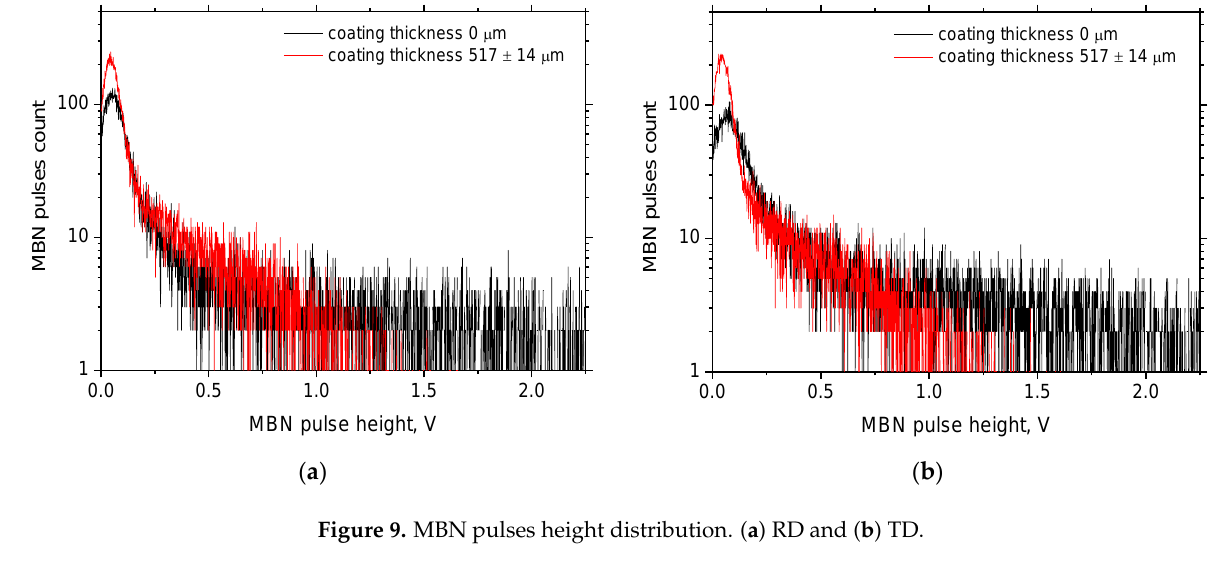
Figure 8. Coating thickness (obtained from the LM observations) versus full width at half maxi- mum ( FWHM ).